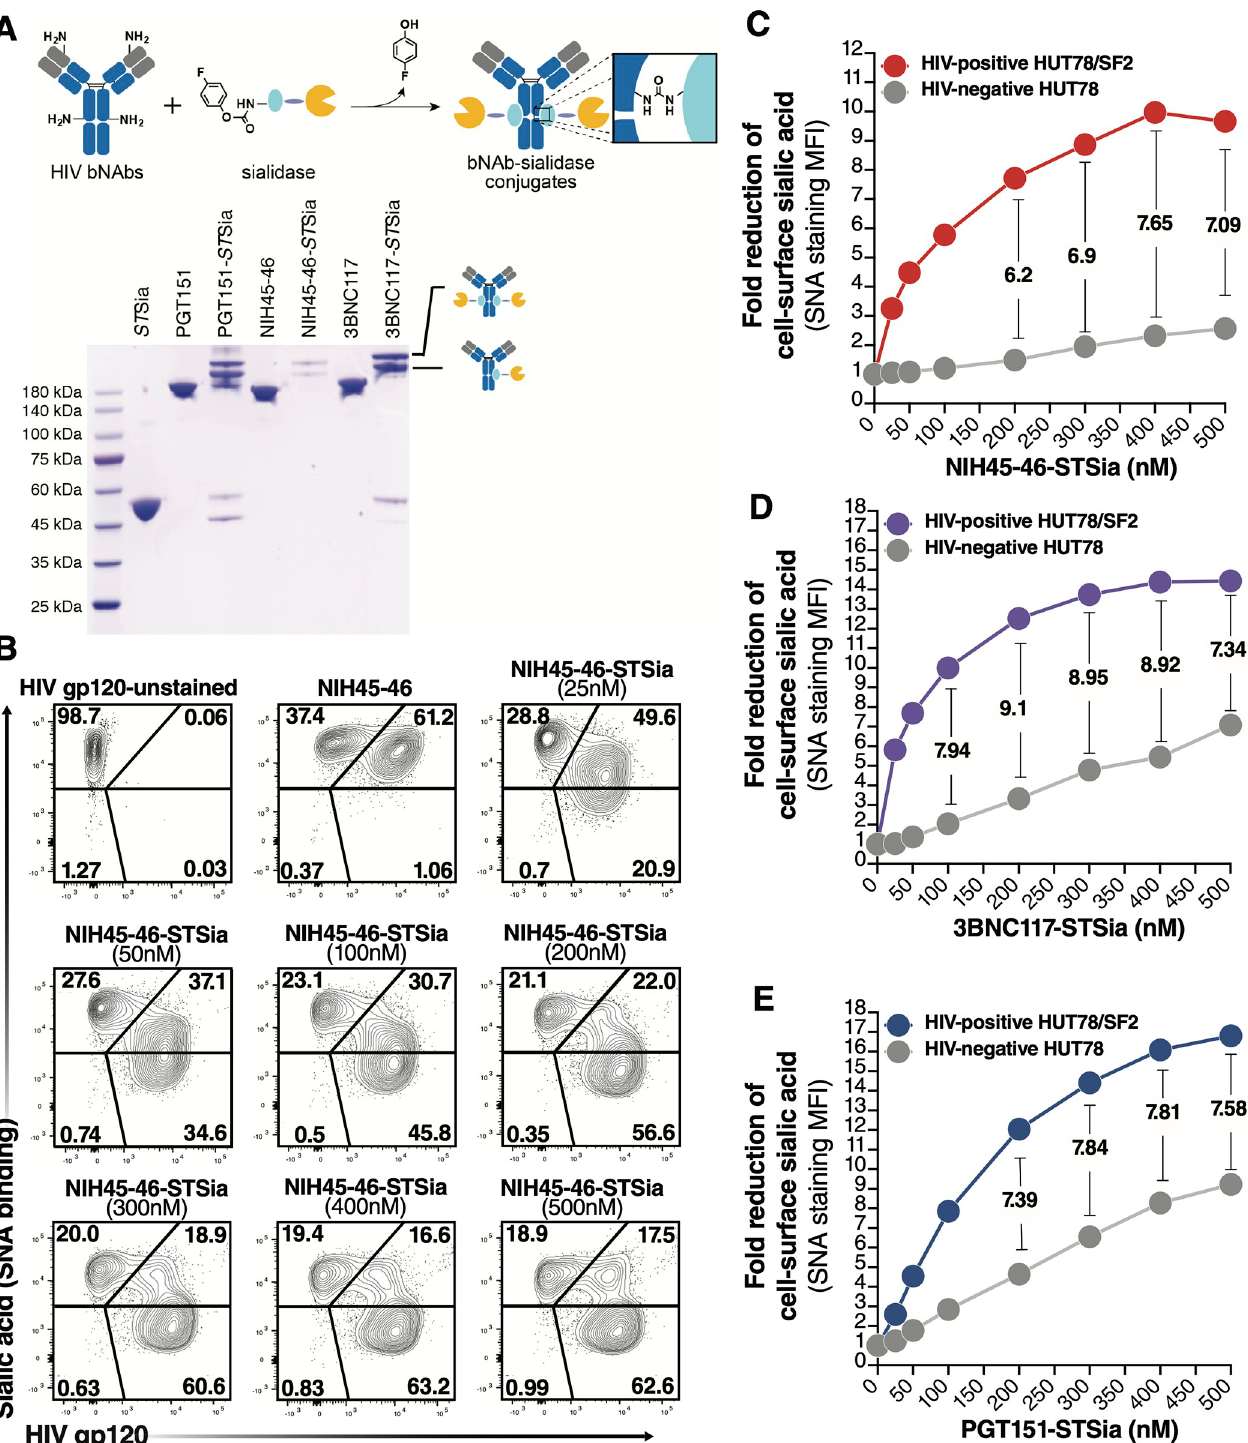
Fig 6. bNAb-Sialidase conjugates selectively target HIV+ cells for desialylation. (A) Top: preparation of site-specifically labeled HIV bNAb-Sialidase (bNAb-STSia) conjugates. Antibody-binding peptide (light blue) genetically fused with Sialidase (yellow) is conjugated to bNAb using pClick. pClick enables a site-specific conjugation between the antibody-binding peptide with payload and Lys337 of antibodies. Bottom: SDS-PAGE analysis with non-reducing buffer of bNAb-Sia conjugates. The two new bands above 180 kDa are consistent with the formation of the mono- or double-STSia antibody complex. (B-C) A mixture of HUT78 cells (HIV -negative ) and HUT78/SF2 cells (HIV + ) was treated with escalating doses of NIH45-46-STSia. HIV gp120 was measured by a